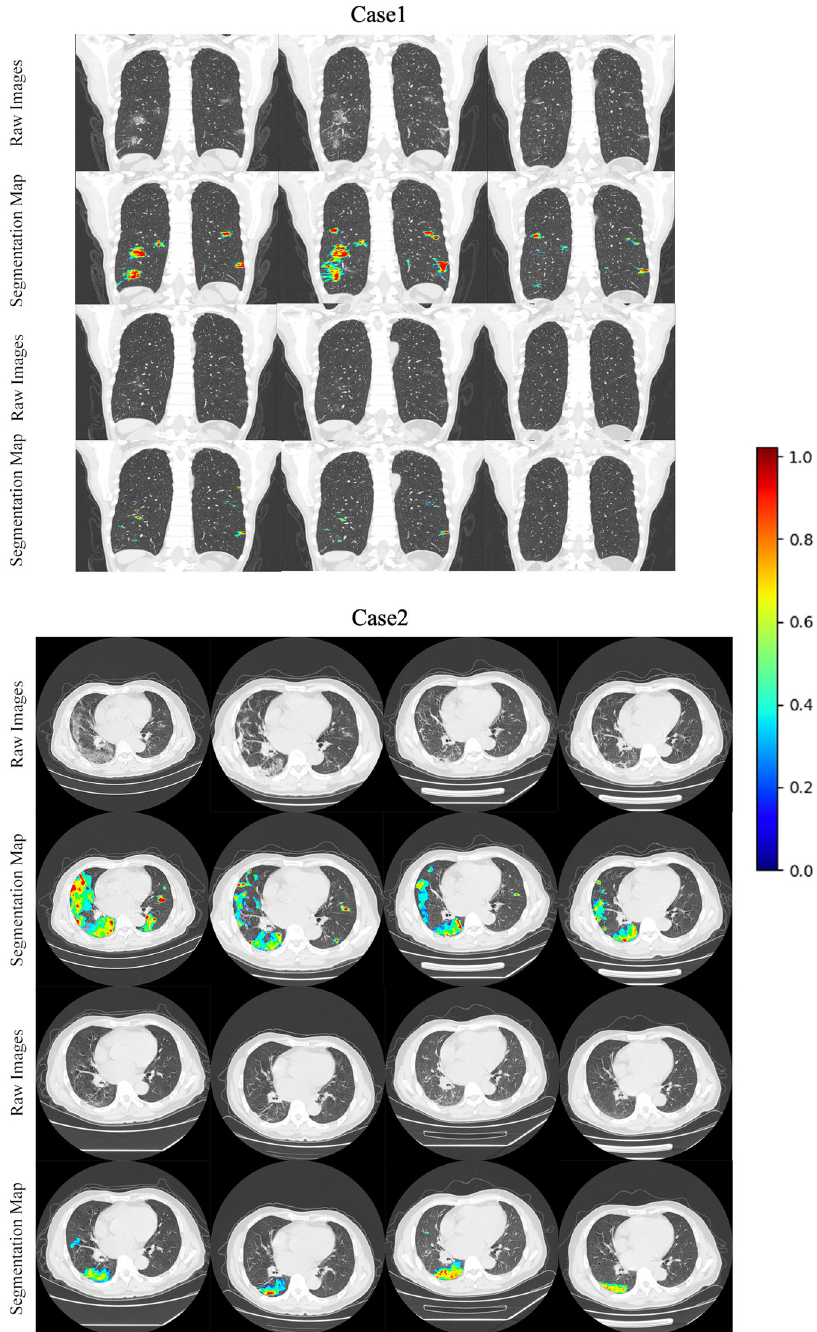
Fig. 5 Two case studies with external longitudinal CT scans relying on dense scoremaps of lesion regions for lesion burden estimation. The raw images are shown accompanied with dense prediction scoremaps with the probability color bar. The CT images are chronologically ordered from left to right, top to down, in accordance to the scanning date as shown in the following Fig. global model with its local data. After an epoch, each node sent back the exchanged the network parameters to update a global model stored at the updated parameters to the central server for the next federated learning central server at a certain frequency (i.e., every training epoch). In each iteration. This process was repeated until the global model converged. iteration of the federated update, the central server fi rst aggregated all the Formally, assume that there are K ( K = 3 in our setting) hospitals for local models and used them to update the global model parameters using collaborative training, with n k as the number of data points in each the Federated Averaging (FedAvg) algorithm 28 . The updated global model hospital k . At the beginning of one federated training round t , the central was generated by using a weighted average of the parameters from all the server fi rst sends the global model with parameters w t to all local hospitals. local models, weighted proportionally to the sample size on each node, Each hospital k then optimizes the received model locally with its own which is provided by local node to the global server. Next, the central dataset for E epochs ( E = 1 in our implementation), and then sends the server distributed the updated global model to the local nodes, then each model update ∇ w tk back to server. Once receiving the updates from all node continued to perform local optimizations based on the updated